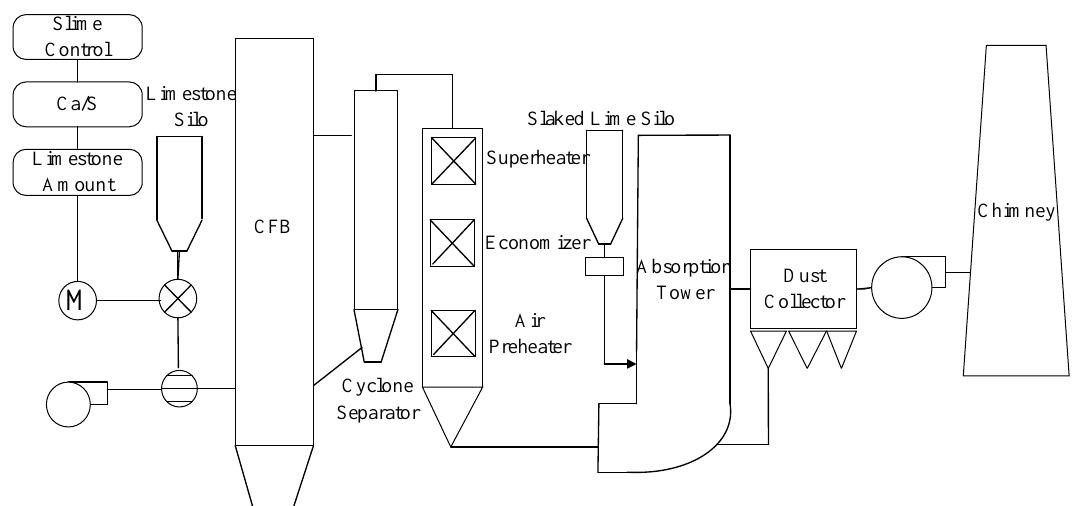
Figure 1. Two-stage desulfurization process diagram of a slime fluidized bed boiler.